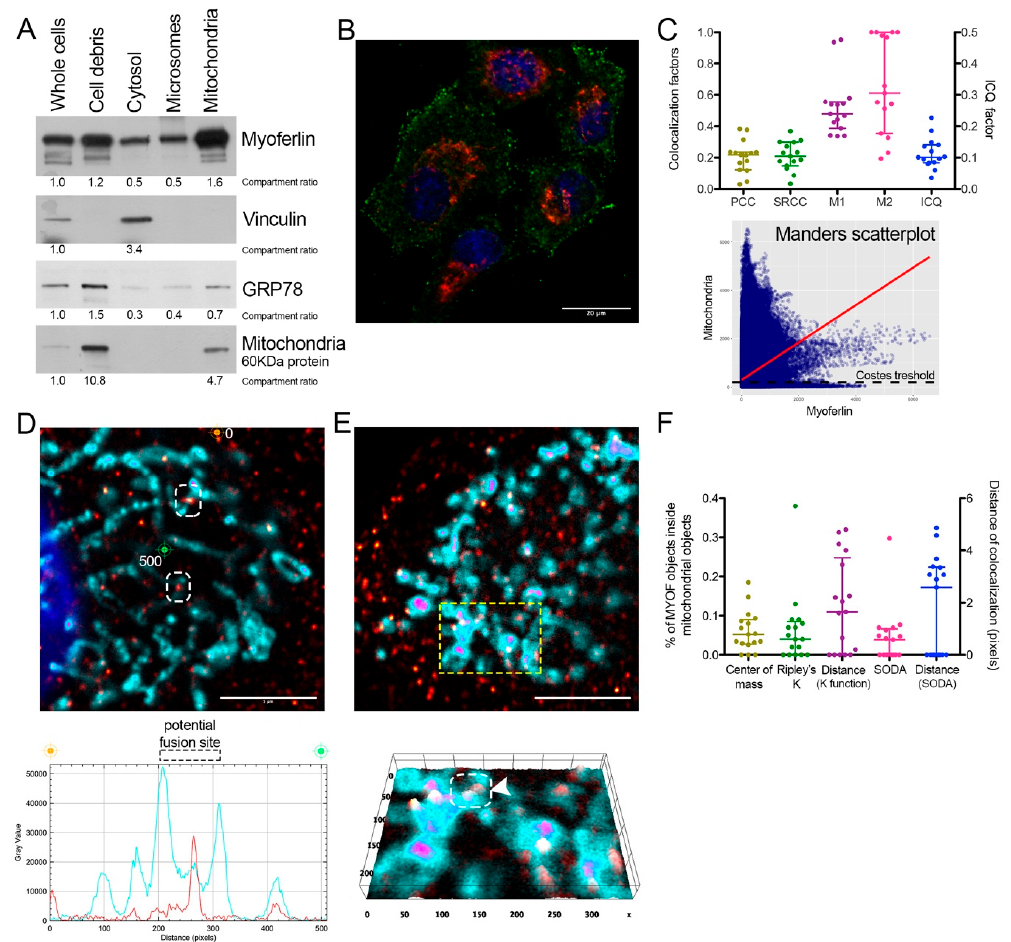
Figure 1. Myoferlin was colocalized with mitochondria in Panc-1 cells. ( A ) Western blot of 6 µg protein samples from whole Panc-1 cells and several cellular compartments isolated from Panc-1 cells. Myoferlin, vinculin, GRP78, and a 60 kDa mitochondrial protein were detected on the same membrane. Compartment relative quantification was performed using ImageJ; ( B ) representative confocal image of nuclei (blue), myoferlin (K-16—green) and mitochondria (113-1—red) immunofluorescence. Scale bar = 20 µm; ( C ) Pearson (PCC), Spearman rank (SRCC) correlation coefficients, Manders’ colocalization coefficients (M1,M2), and intensity correlation quotient (ICQ) calculated on 17 independent microscopic fields. Manders scatterplot, associated with its linear regression (red line), shows the correlation between the intensity of each pixels in each channel. ( D,E ) Deconvoluted confocal image of nuclei (blue), myoferlin (K-16—“hot” red scale), mitochondria (113-1—“cold” cyan scale). Scale bar = 5 µm. Regions surrounded by white dashed boxes are putative mitochondrial fusion sites. ( D ) Channel intensity profile was established following the segment between orange (0-pixel position) and green (500-pixel position) cross marks; ( E ) The region surrounded by a yellow dashed box was used to generate the 2D intensity profile. Regions surrounded by white dashed box and marked by white arrow head is a putative mitochondrial fusion site; ( F ) percentage of myoferlin-positive objects ( N = 4286) with the center of a mass overlapping mitochondrial object ( N = 459), a percentage of myoferlin-positive object colocalizing mitochondrial object calculated by fitting of the Ripley’s K function or by statistical object distance analysis (SODA). Colocalization distances in pixels were measured in both cases. All experiments were performed as three independent biological replicates.